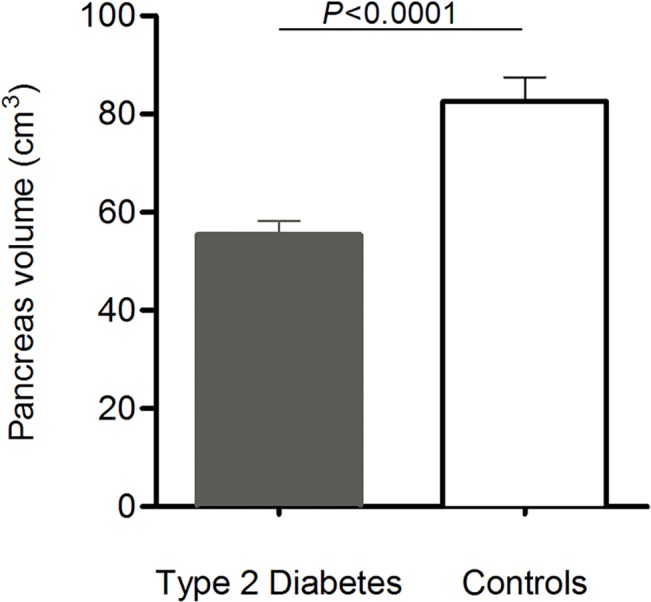
Mean pancreas volume in the type 2 diabetes and control groups (error bars show standard error of the mean).Pancreas volume was decreased by 33% (p<0.001 by Mann- Whitney U test).